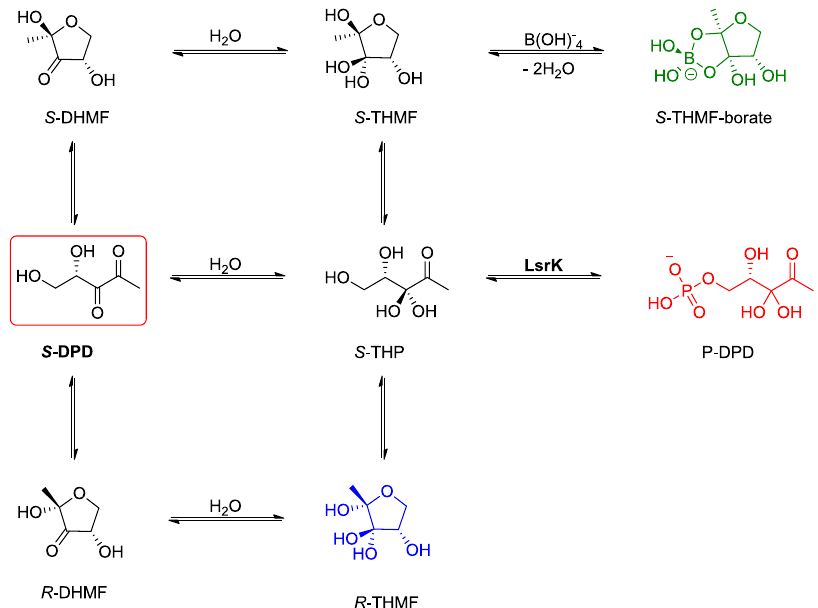
Figure 1. ( S )-DPD in an aqueous medium: all species in equilibrium. (2 S ,4 S )-2,4-dihydroxy-2- methyldihydrofuran-3-one ( S -DHMF); ( S )-4,5-dihydroxy-2,3-pentanedione (DPD); (2 R ,4 S methyldihydrofuran-3-one ( S - DHMF); ( S )-4,5-dihydroxy-2,3-pentanedione (DPD); (2 R ,4 S )-2,4- dihydroxy-2-methyldihydrofuran-3-one tetrahydroxytetrahydrofuran ( S THMF); ( S )-3,3,4,5-tetrahydroxy-2-pentanone ( S - THP); (2 R ,4 S )-2- methyl-2,3,3,4-tetrahydroxytetrahydrofuran ( S )-3,3,4,5-tetrahydroxy-2-pentanone-5- phosphate (P-DPD).